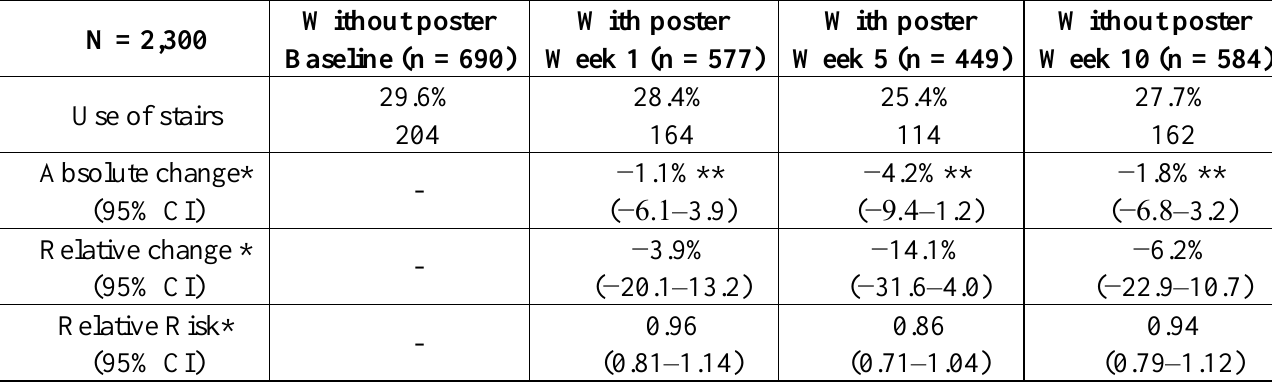
Table 2. Stair use of men at different points in